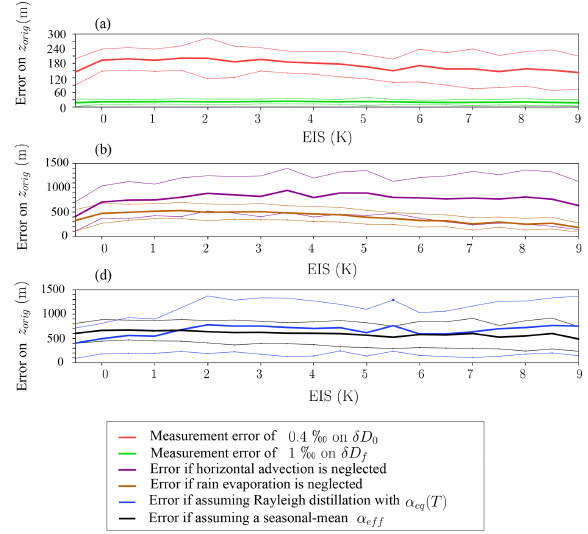
Figure 14. Errors when estimating z orig from δD 0 observations, as a function of EIS, as predicted by LMDZ. (a) Error we would make if δD 0 is measured with a 1‰ error (red), and error we would make if δD f is measured with a 1‰ error (green). (b) Error we would make if we neglect horizontal advection effects (purple) and rain evaporation effects (brown). (c) Error if one uses α eq as a function of local temperature to estimate α eff (blue), error if one uses the seasonal-mean profile instead of the daily profile to estimate α eff (black). The standard deviations among all daily errors estimated in each bin of EIS are also